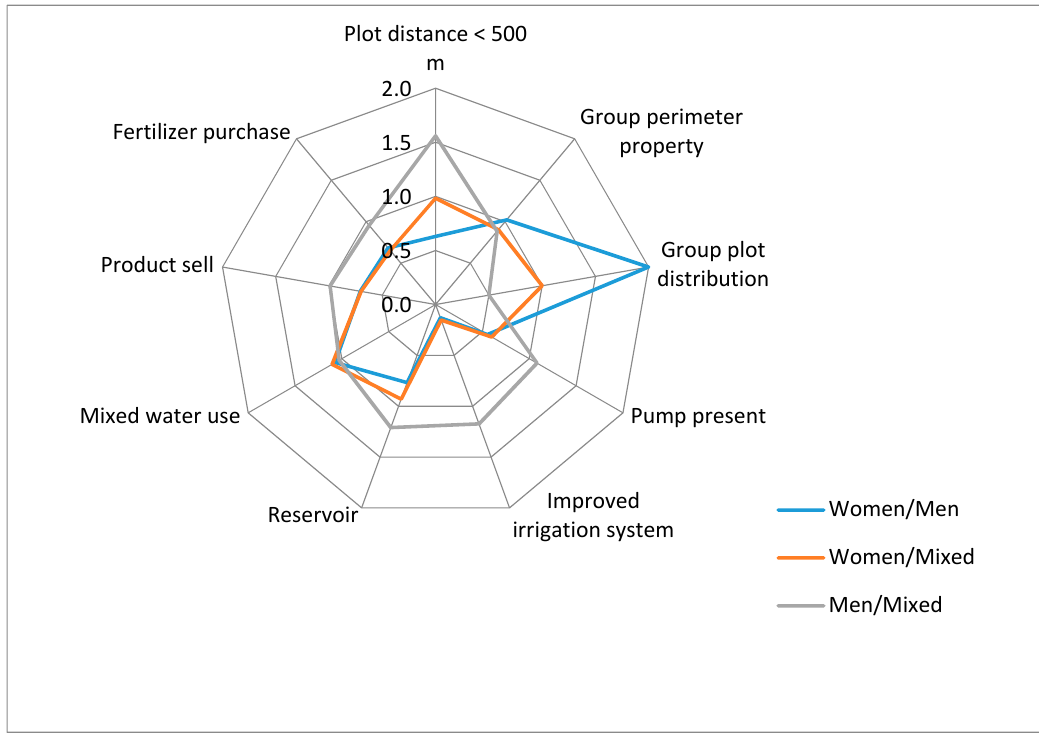
Figure 2. Indicators’ ratio distribution.